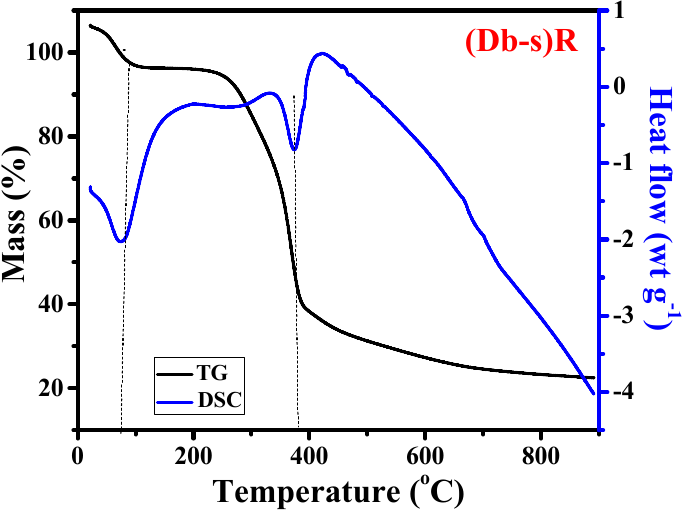
Figure 1. Thermogravimetric (TG) and differential scanning colorimetry (DSC) curves of raw wood powder of Dalbergia sisoo (Db-s) R.